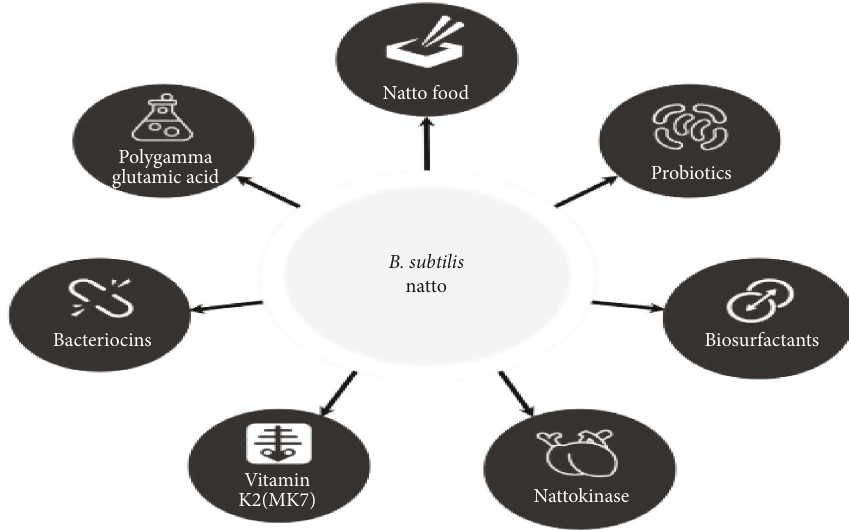
Figure 2: Potential effects of Bacillus subtilis natto . Source: [37,